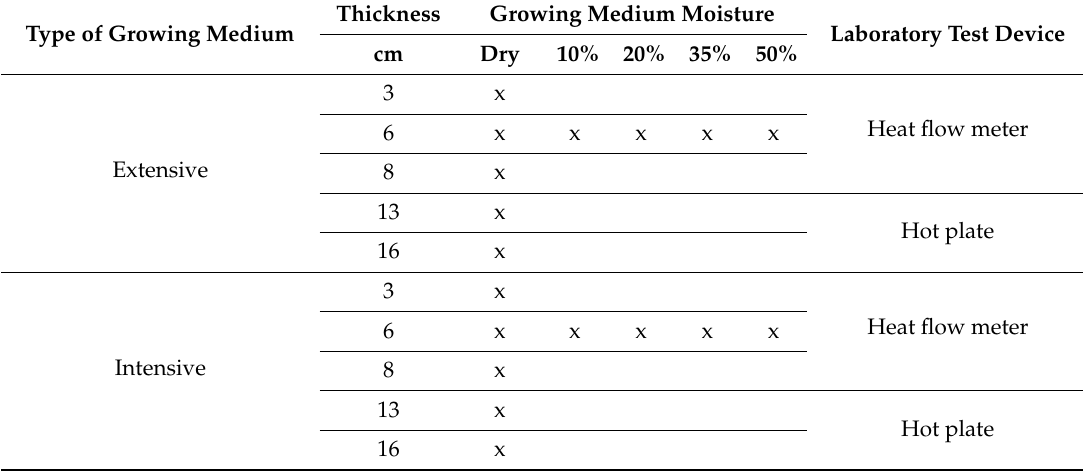
Table 1. Test sequence for each of the four factories: 9 tests for the extensive sample, 9 tests for the intensive sample (for a total of 72